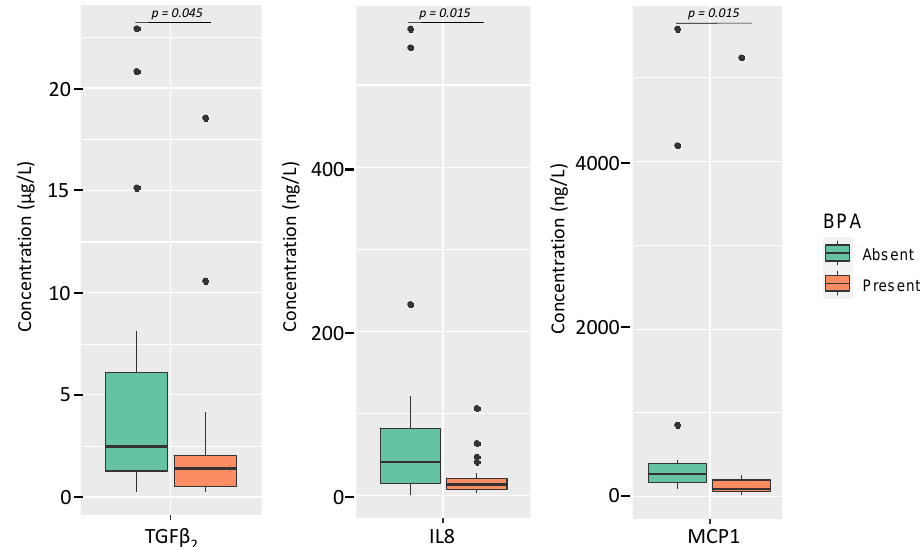
Figure 5. Box-plots showing the concentration of selected immunological compounds according to the presence (green) or absence (orange) of total BPA in the samples. In the box-plots, the box represents the values of the interquartile ranges, and the median is represented as a line in the box. Outliers are represented as dots. Kruskal-Wallis tests were used to evaluate differences in the concentrations of the immunological compounds between milk samples where BPA was present and those where it was absent.